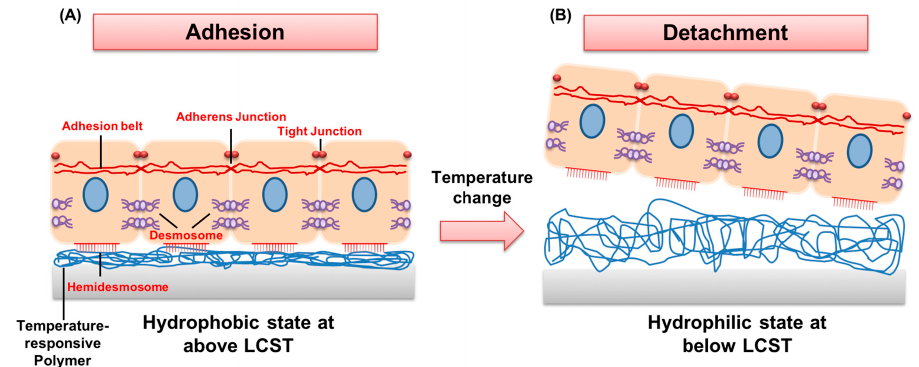
Figure 2. A temperature-responsive matrix showing the attachment and detachment of cell sheets while preserving cell–cell junctions. ( A ) At 37 °C, the cells attach to the surface that is hydrophobic (above lower critical solution temperature). Cells connect to each other by various cell-to-cell junctions and deposit ECMs. ( B ) At values below LCST, cells detach from the hydrophilic surface. Temperature-responsive culture surfaces are able to preserve the pre-existing cell-to-cell junctions and cell-secreted extracellular matrices (ECMs).